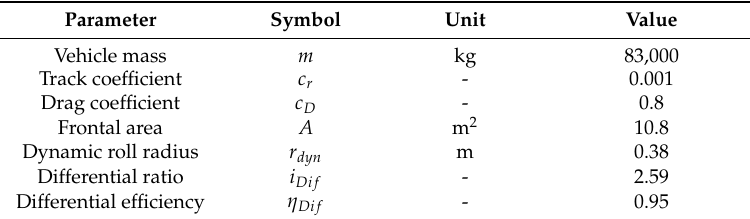
Table 2. Vehicle model parameters.